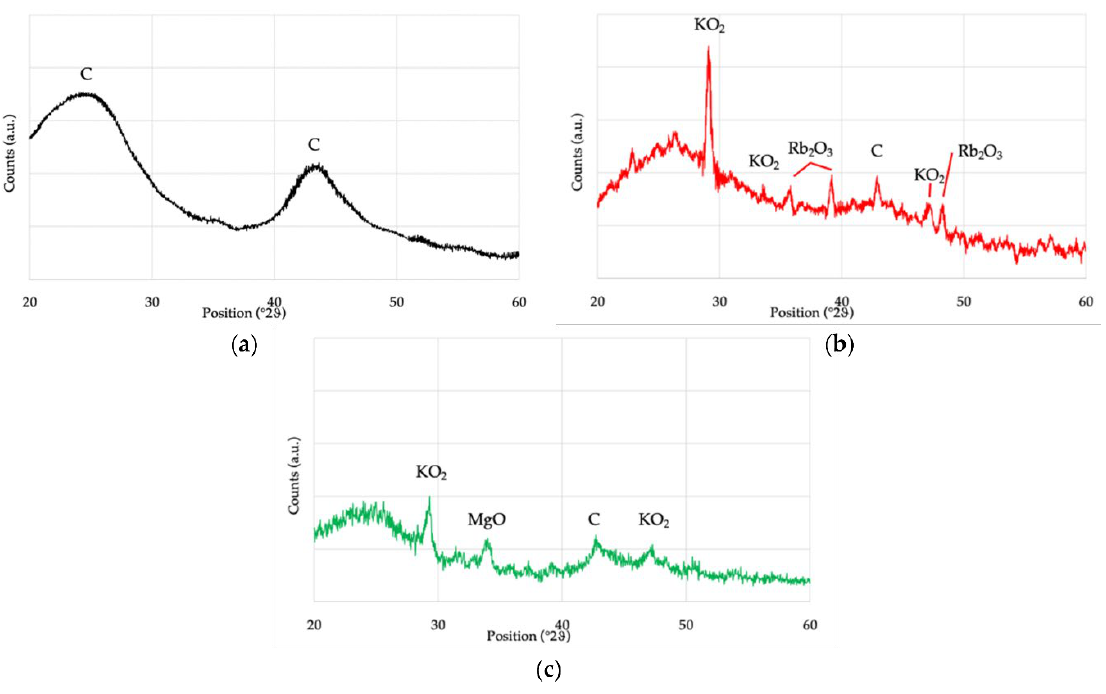
Figure 8. XRD spectra of CARBOSORB NC 1240 ® ( a ), AMBIOTON ® ( b ), and RE-CHAR ® ( c ).